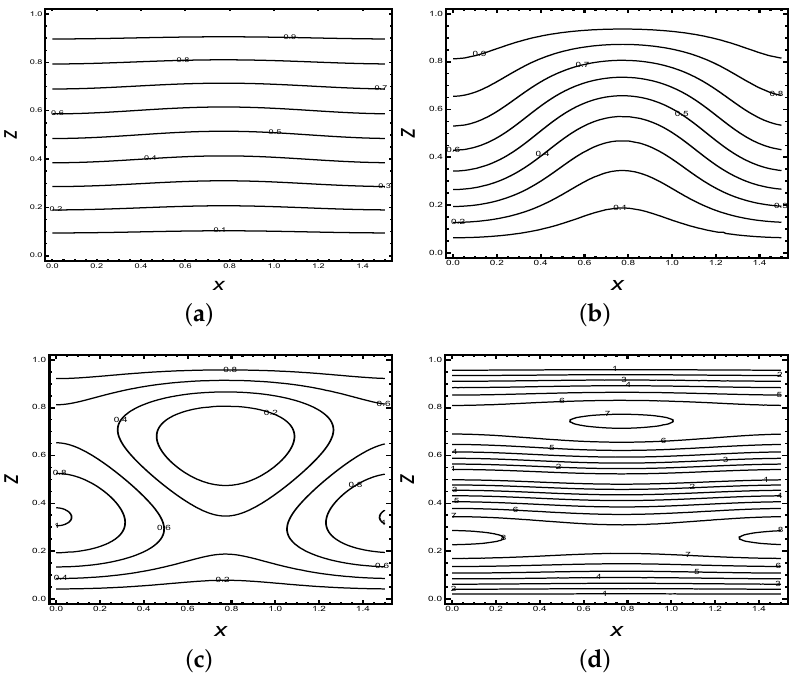
Figure 4. Isotherms for the fixed values of parameters at different scaled time ( a ) τ = 0.1, ( b ) τ = 1.0, ( c ) τ = 2.0, ( d ) τ = 2.5 for the fixed values of Pr = 25, Da = 0.3, ω = 2, δ 1 = 0.05, Γ p = 0.5 and Ta =